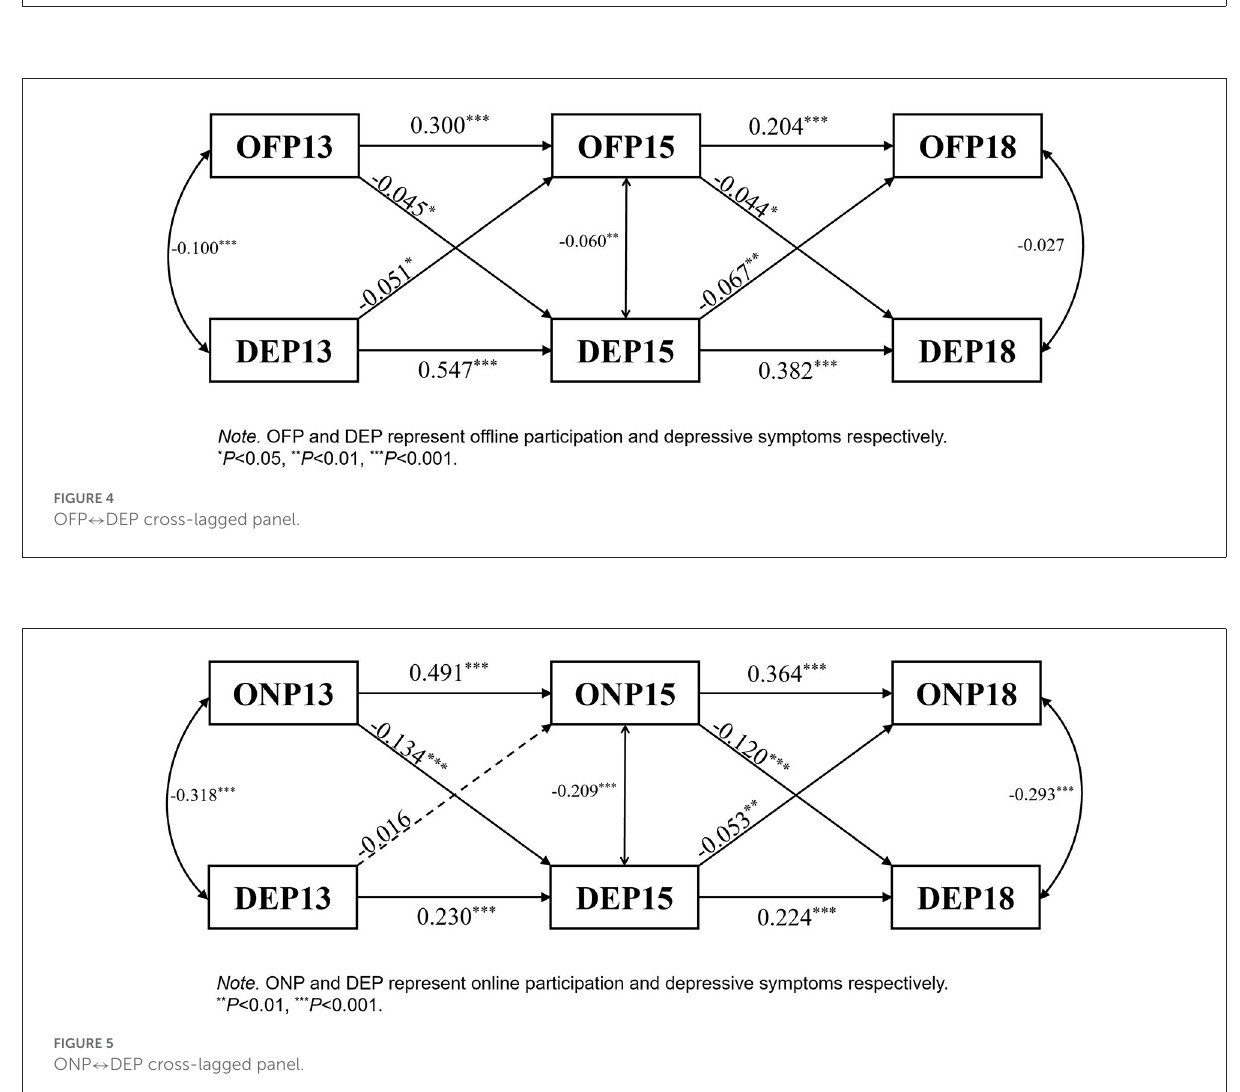
FIGURE5 ONP ↔ DEP cross-lagged